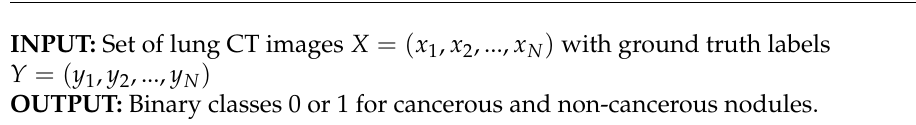
Algorithm 1 Pseudocode of pre-processing step in NG-CNN algorithm.